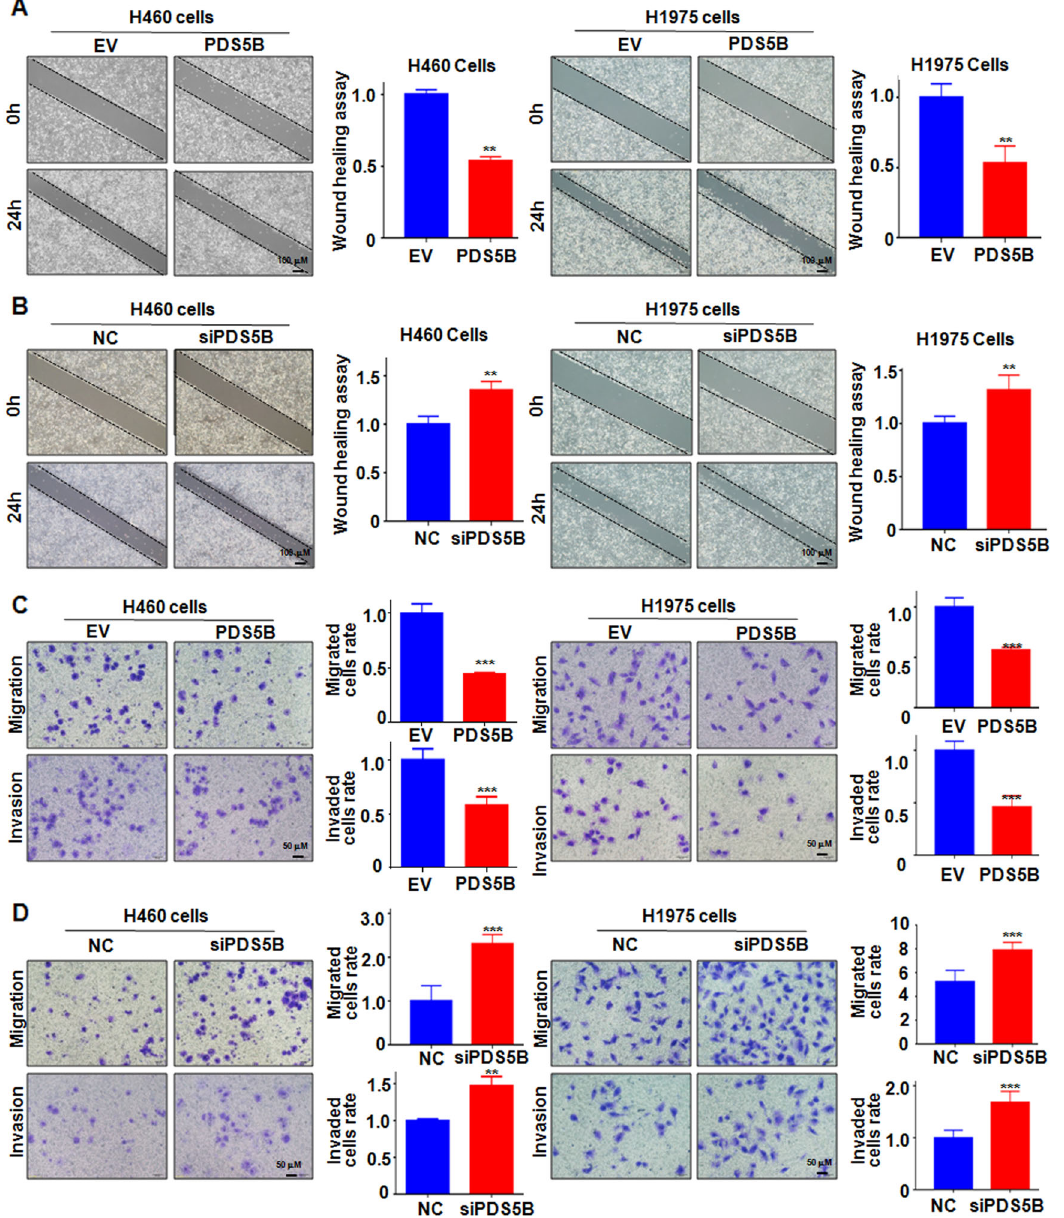
Fig. 2 PDS5B overexpression retards cell motility. A Left panel: wound closure was examined by wound-healing assays in NSCLC cells after PDS5B cDNA transfection. Right panel: quantitative data of wound closure. ** P < 0.01 vs EV group. EV empty vector, PDS5B PDS5B cDNA. EV group is the control group. B Left panel Wound closure was detected by wound-healing assays in NSCLC cells after PDS5B siRNA transfection. Right panel: quantitative data of wound closure. ** P < 0.01 vs NC group. NC nonspeci fi c control siRNA, siPDS5B PDS5B siRNA. NC group is the control group. C Left panel cell motility was examined in NSCLC cells after PDS5B cDNA transfection. Right panel: quantitative data of cell motility. *** P < 0.001 vs EV group. EV group is the control group. D Left panel: cell motility was measured in NSCLC cells after PDS5B siRNA transfection. Right panel: quantitative data of cell motility. ** P < 0.01, *** P < 0.001 vs NC group. NC group is the control group. Data are shown as mean ± SD from experiments in